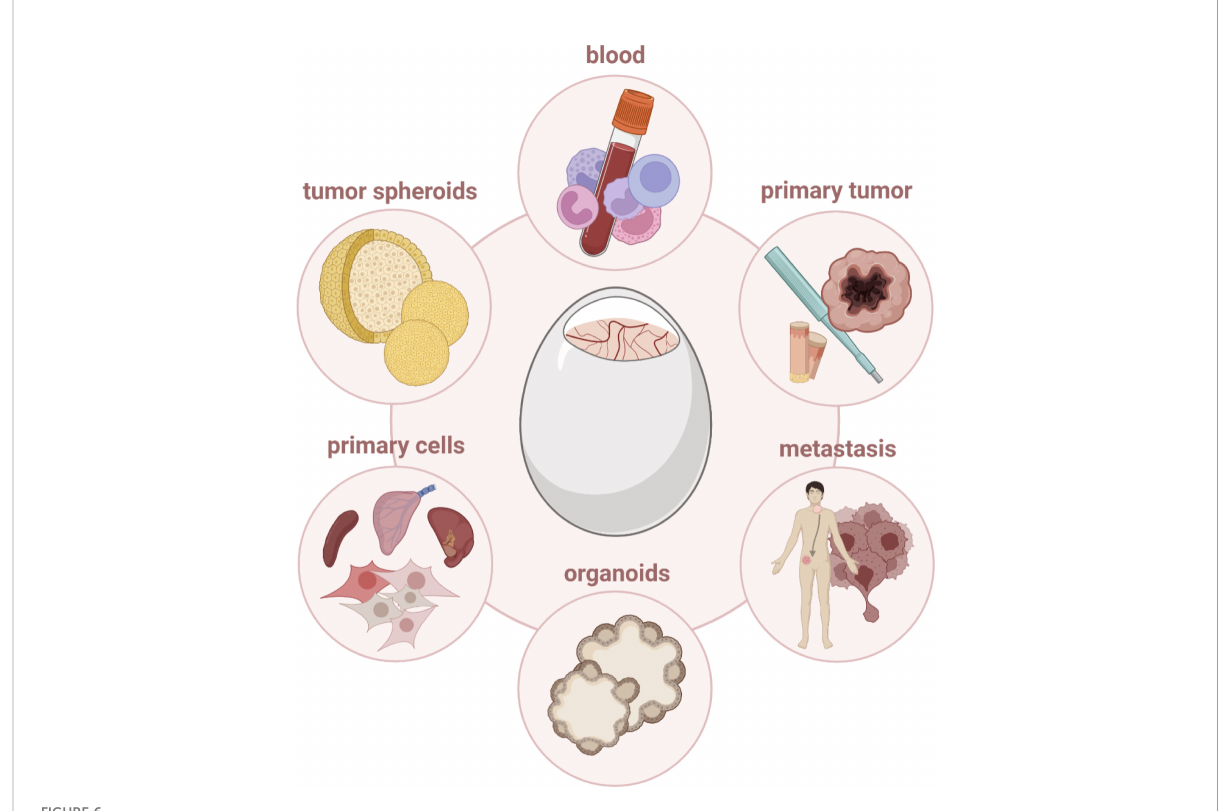
FIGURE 6 Cells and tissues that can be engrafted in ovo